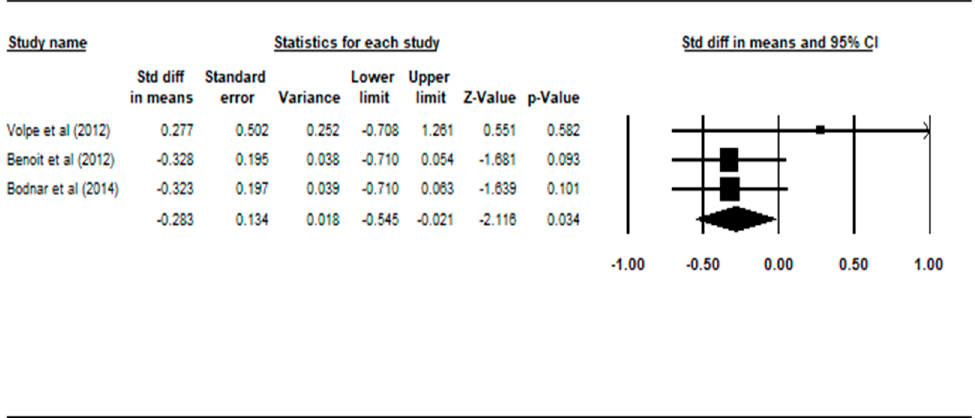
Figure 5. Forest plot: NDS vs. HC, white matter volume. Abbreviations: Std diff, standard difference; CI, confidence interval.